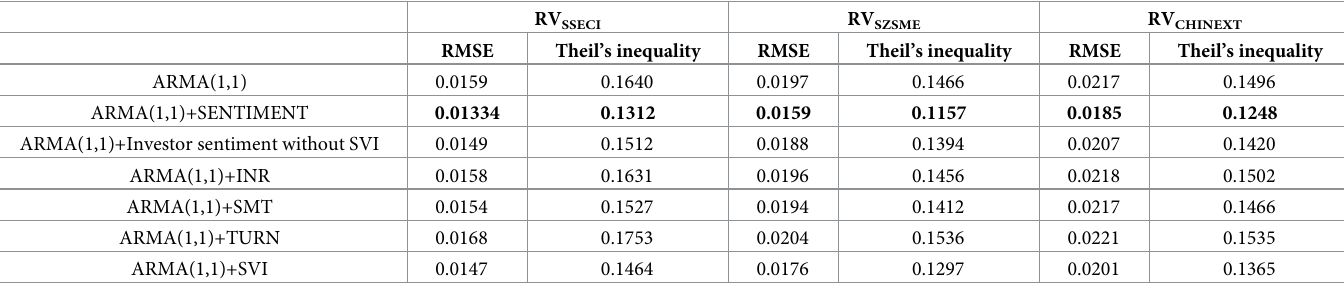
Table 9. The out-of-sample prediction performances of different model